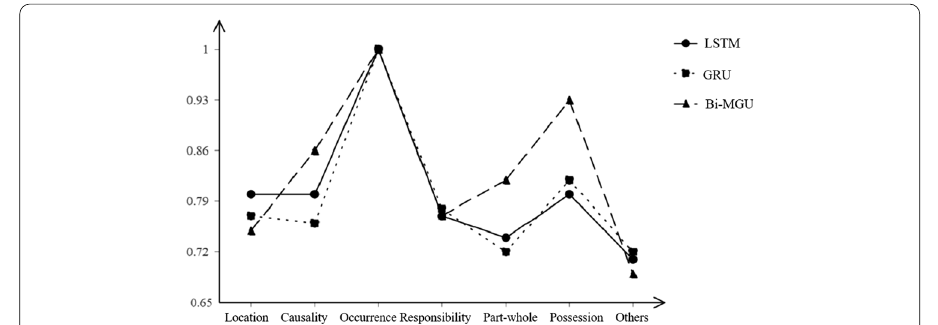
Fig. 5 Comparison on recall of different relation extraction approaches, where each type of relation is used as a data point to tease out the effectiveness of the proposed model